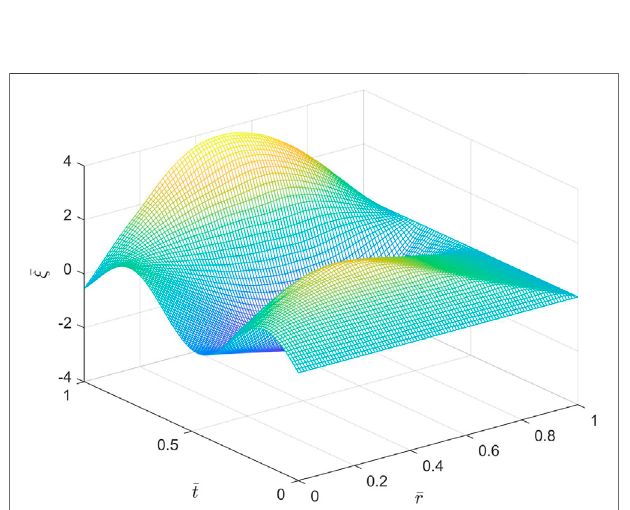
FIGURE 6 | Spatio-temporal variations of the dimensionless axial displacement (cid:2) ξ ( (cid:2) r , (cid:2) t ) for the variable fractional order α ( t ) corresponding to the case of stepwise